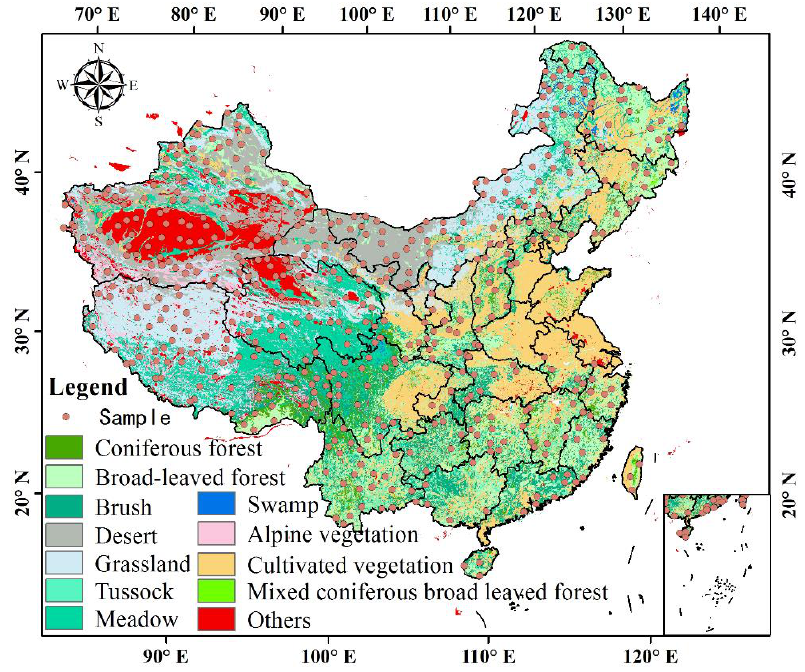
Figure 6. Vegetation distribution map at scale a of 1:1,000,000 and CSCS model validation samples.